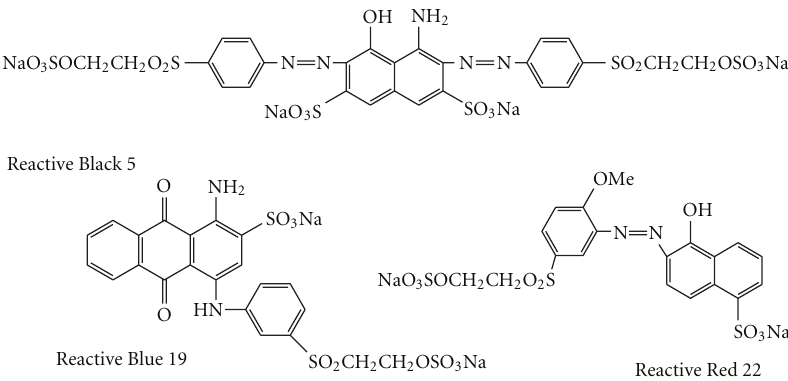
Figure 1: Chemical structures of dyes used in the